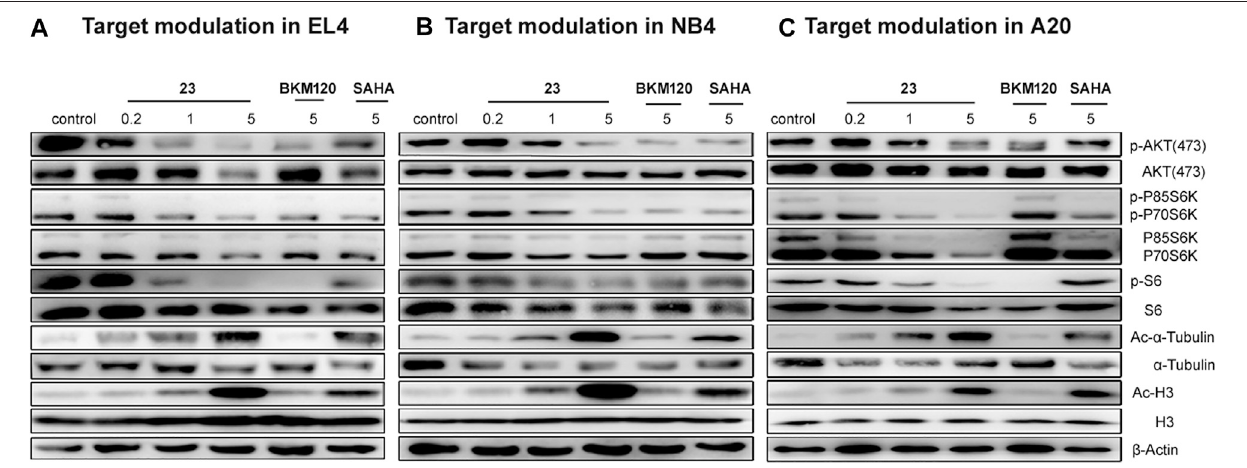
FIGURE 2 | Modulation of the PI3K/AKT/mTOR and HDAC pathways in three hematologic tumor cell lines. (A) EL4, (B) NB4, and (C) A20 cells were treated with several concentrations of compound 23 for 24 h. Whole cell lysates were subjected to western blotting.